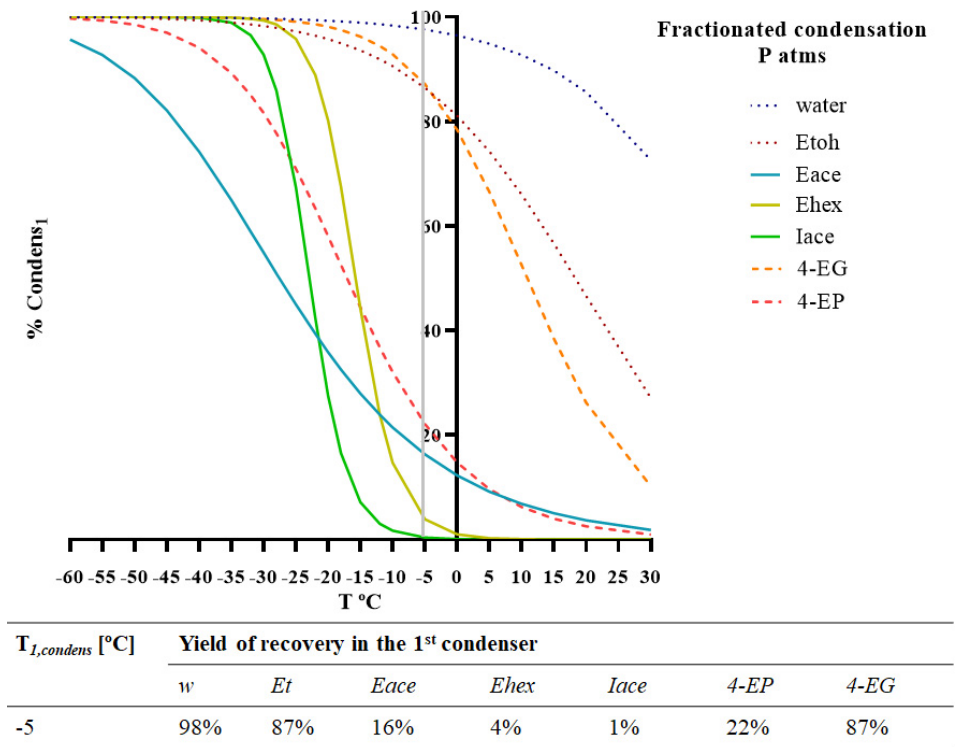
Figure 5. Model simulation of fractionated condensation for two different chemical families (esters and ethyl phenols) included in the red wine model solution. Percentage of condensation of each compound present (water, ethanol, ethyl acetate, ethyl hexanoate, isoamyl acetate, 4-ethyl phenol, and 4-ethyl guaiacol) in the 1st condenser ( %Condens i1 ). Operating conditions: T feed = 30 °C; p perm = 101 kPa.